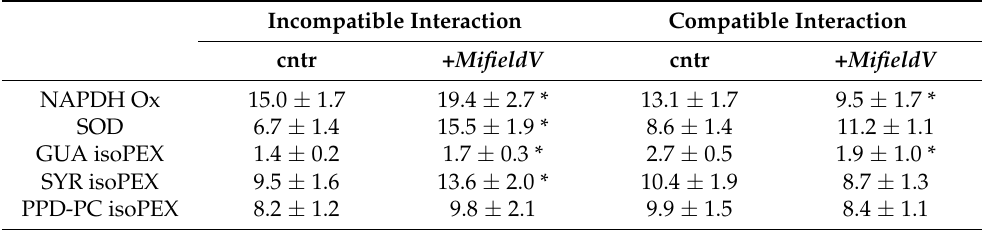
Table 2. Different enzyme activities in microsomes extracted from roots of near-isogenic tomato plants resistant (Motelle) and susceptible (Moneymaker) to RKNs. Plants were inoculated by MifieldV or left uninoculated and used as controls (cntr). Extractions were carried out at 5 dpi. O 2 −• generating activity (NAPDH Ox) was expressed as nmoles cyt. c reduced min − 1 mg − 1 prot, whereas SOD and isoPEXs as Units mg − 1 protein. Values are means ( n = 9) ± SD. Asterisks indicate significant difference with respect to controls according to a paired t -test ( p <